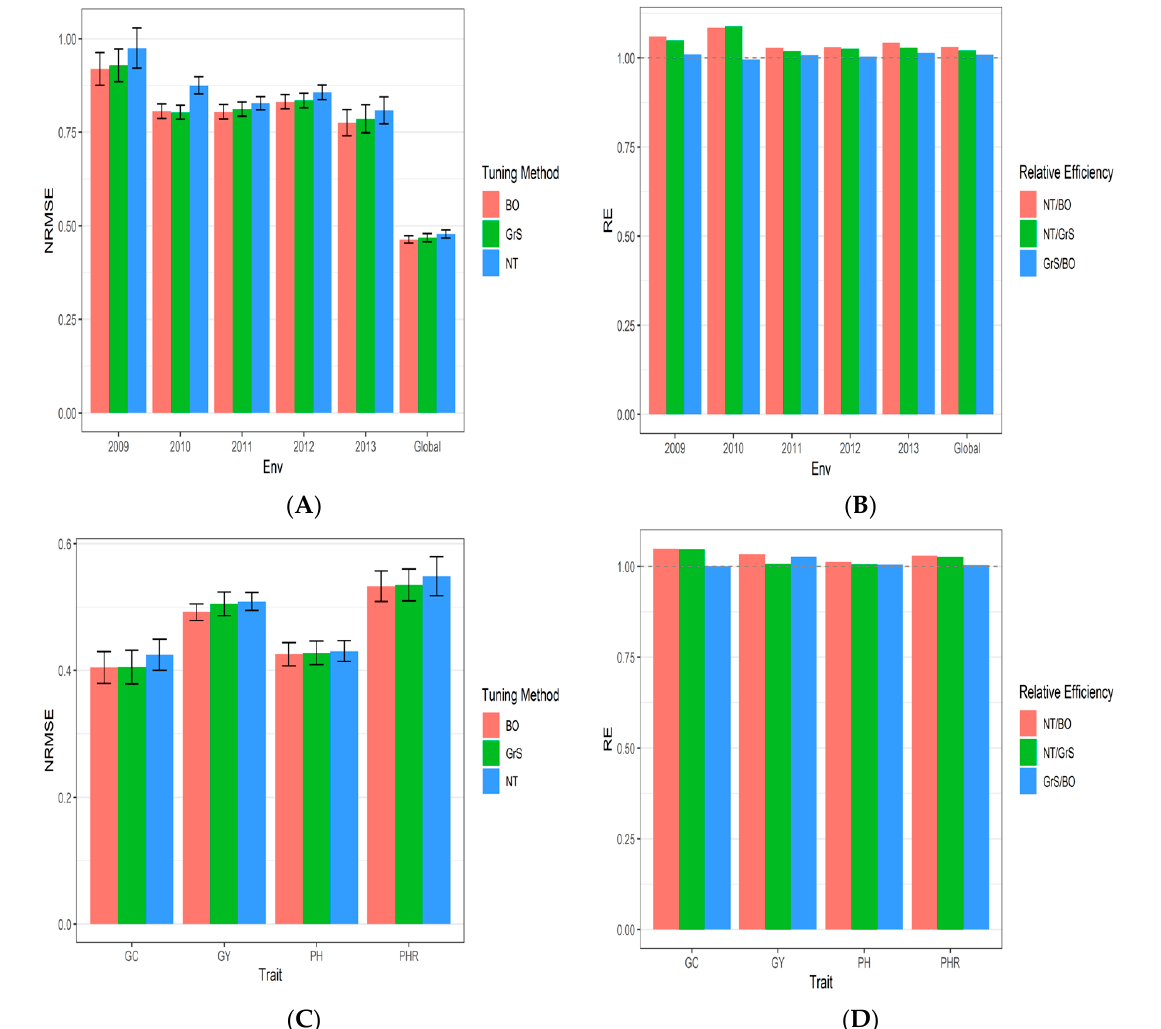
Figure 1. ( A ) The prediction performance for dataset 1, Japonica dataset in terms of normalized root mean squared error (NRMSE) for each year (2009–2013), across years (Global), and across traits with three strategies of tuning (BO, GrS and NT) under 7 Fold Cross-Validation (7FCV). ( B ) The relative efficiency for each environment (2009–2013) and across environments (Global) and across traits (CG, GY, PH and PHR) with three strategies of tuning (BO, GrS and NT) under 7 Fold Cross-Validation (7FCV). ( C ) The prediction performance in terms of normalized root mean squared error (NRMSE) for each trait (CG, GY, PH and PHR) across years with three strategies of tuning (BO, GrS and NT) under 7 Fold Cross-Validation (7FCV). ( D ) The relative efficiency for each trait (CG, GY, PH and PHR) across years with three strategies of tuning (BO, GrS and NT) under 7 Fold Cross-Validation (7FCV). When RE > 1 the denominator method outperforms the numerator in terms of prediction performance.